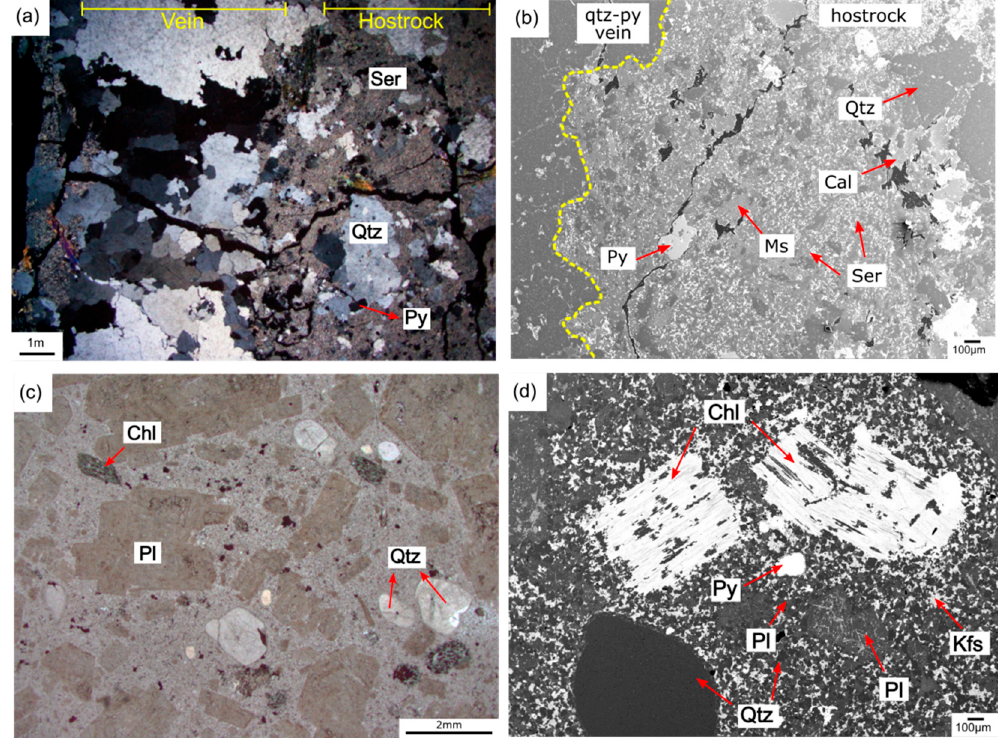
Figure 3. ( a ) Photomicrograph of sericitized quartz porphyry (221 m depth), cross-polarized light. ( b ) Backscattered electron (BSE) image of quartz porphyry and vein. ( c ) Tonalite/granodiorite porphyry (567 m depth), plane-polarized light. ( d ) Representative BSE image of the sample shown in ( c ). Mineral abbreviations are after [24].